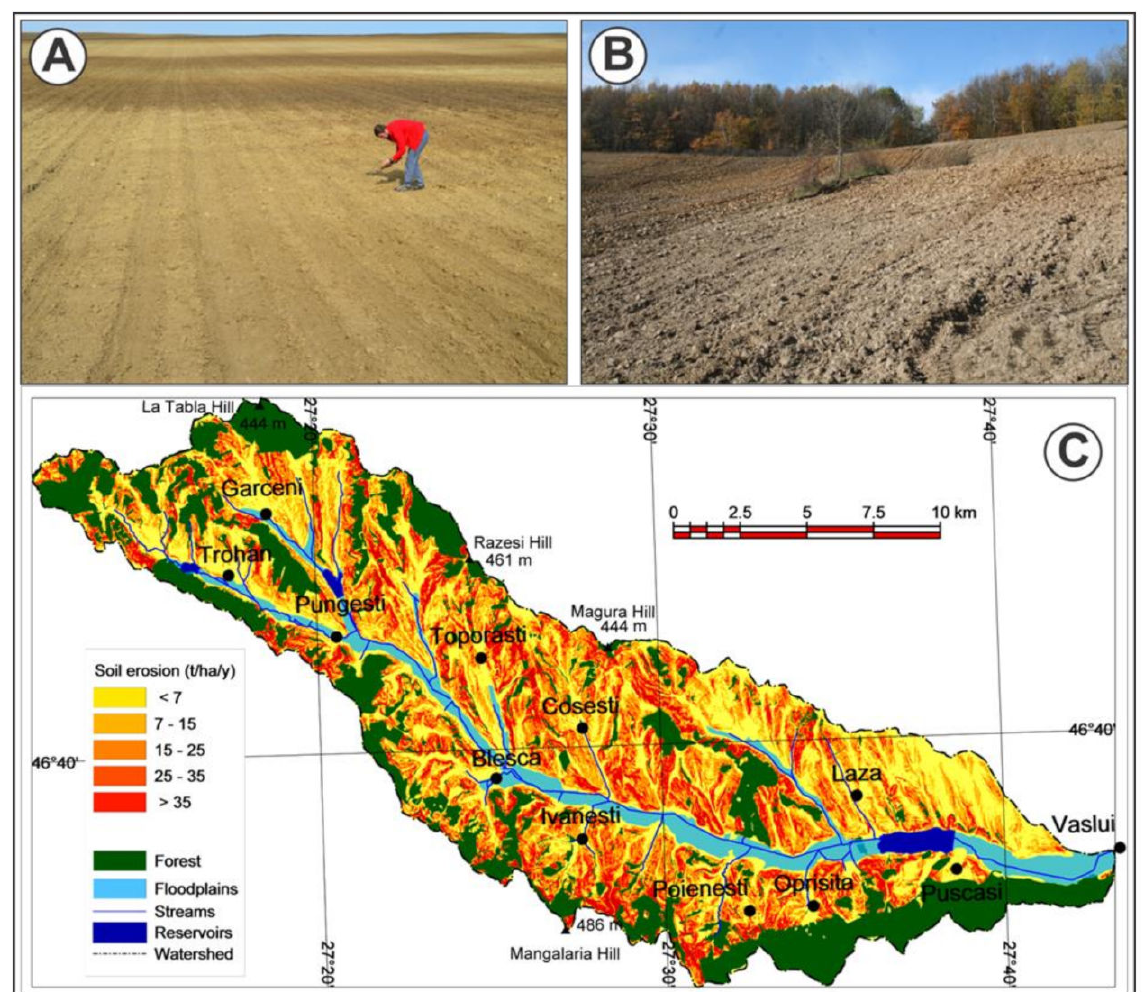
Figure 3. Excessive soil erosion under cambic Chernozems in the left side of Harsova valley on 4 April 2016 ( A ), severe erosion under Luvisols from upper Racovitza on 20 October 2013 ( B ), and map of annual soil losses on agricultural land in the Racova Catchment ( C